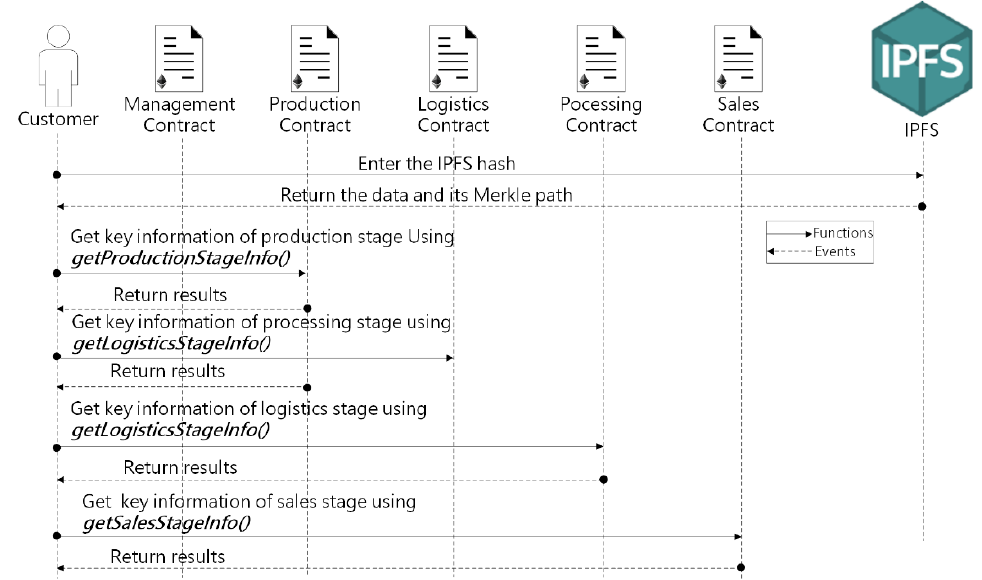
Figure 8. Sequence diagram showing interactions among the customers with the smart contracts and IPFS.